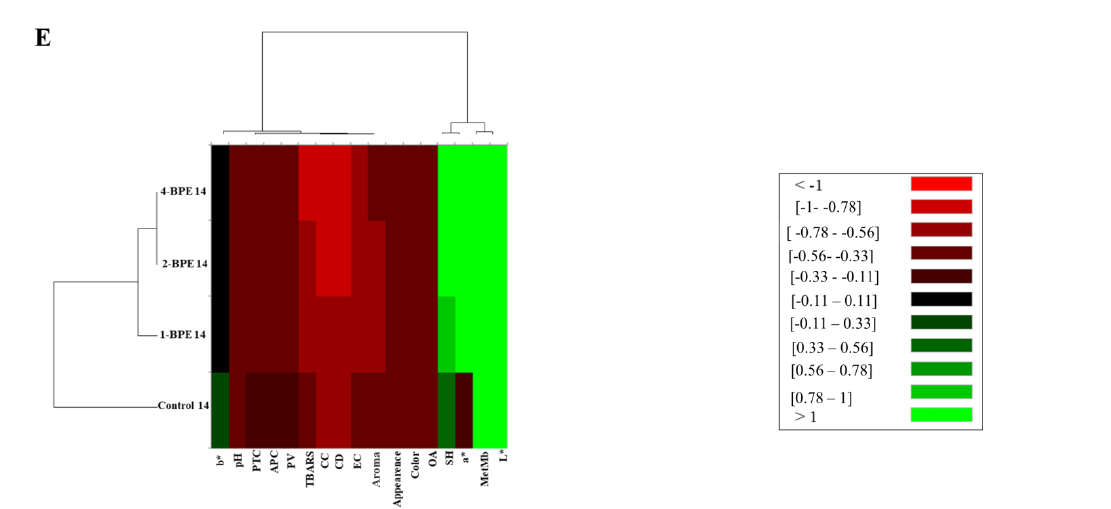
Figure 7. Heat maps of physicochemical, microbial growth, color, and sensorial property values of packaged raw meat samples on ( A ) day 0; ( B ) day 3; ( C ) day 7; ( D ) day 10; and ( E ) day 14 of storage.